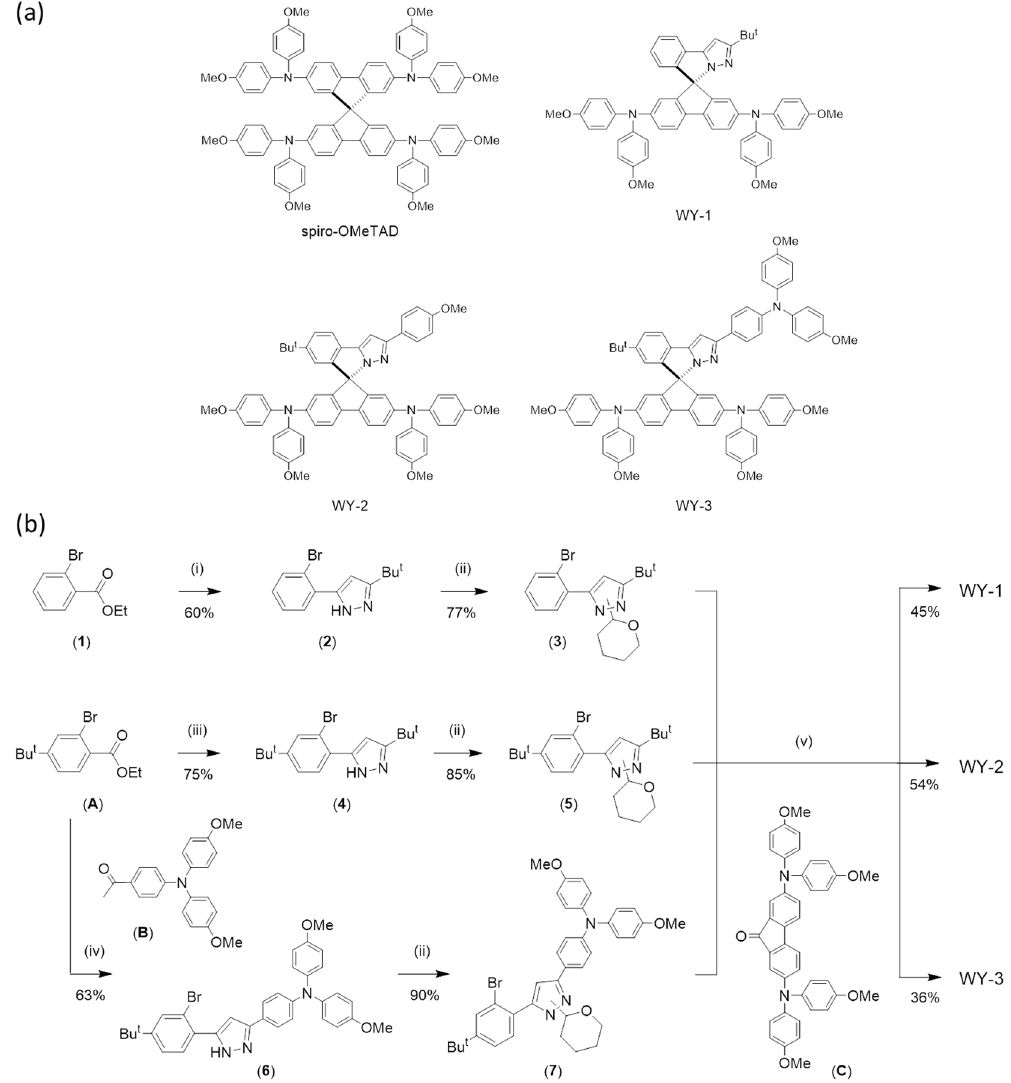
Figure 1. ( a ) Chemical structures of WY-1, WY-2 and WY-3 compared with Spiro-OMeTAD. ( b ) Synthetic routes for the studied